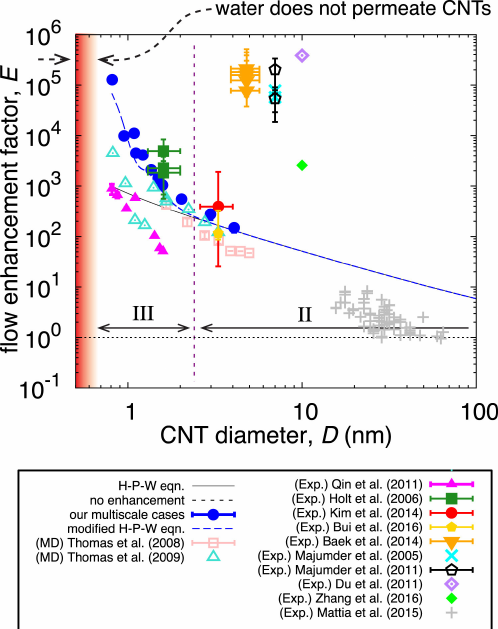
Figure 8. Dependence of the flow enhancement E for long CNTs with diameter D . Comparisons between Borg et al.’s multiscale MD results, their calibrated H-P-W equation, the unmodified H-P-W equation, other full MD simulations and flow experiments (see Reference [90] and references therein). Borg et al. divided the figure into three regimes: Regime I (not shown) where no-slip flow equations can be used (D ≥ 1µm), Regime II , where fixed slip-flow can be used, and Regime III (D ≤ 2nm) where diameter-dependent slippage must be accounted for. Reprinted with permission from Ref.